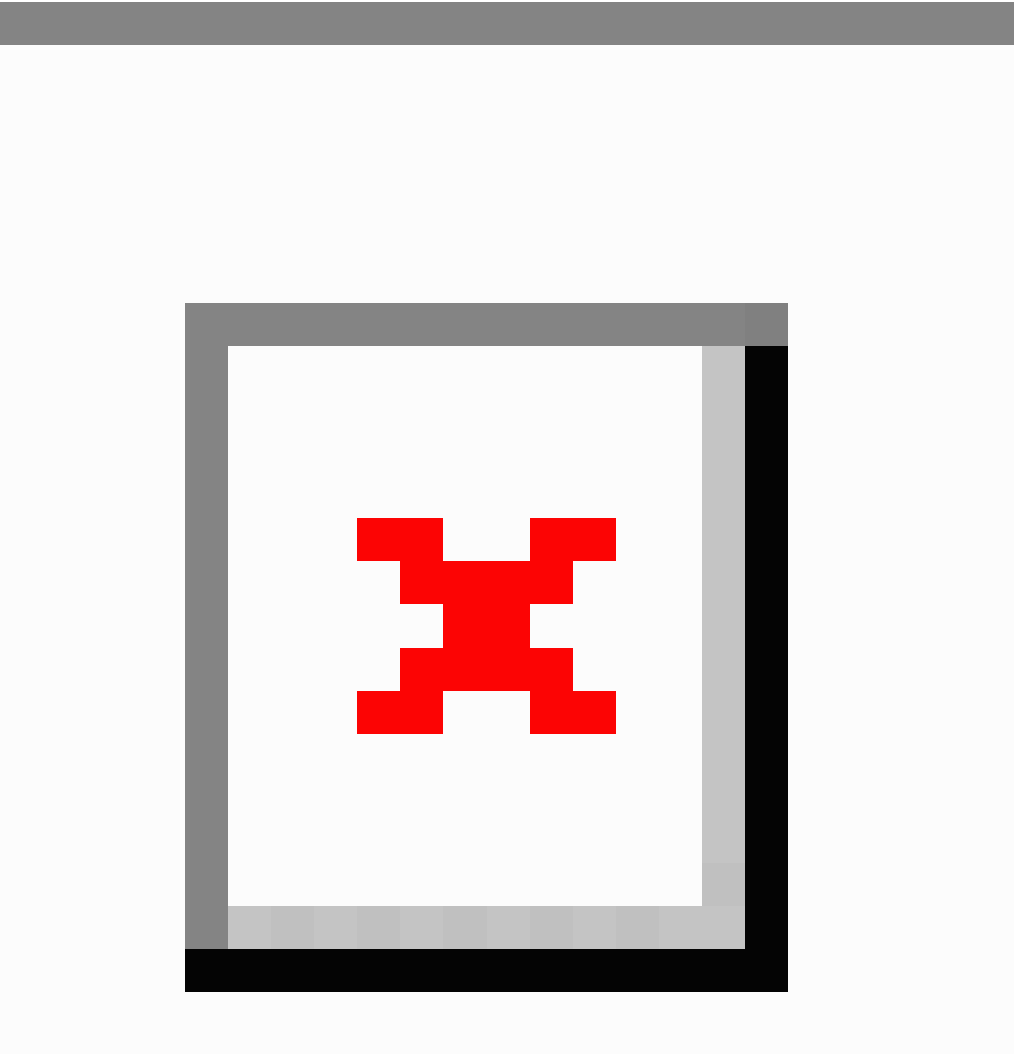
Figure 1. Mean implementation adherence rates of 130 users of the Perx app over 6 months. The shaded area below 80% indicates less than optimal adherence based on the